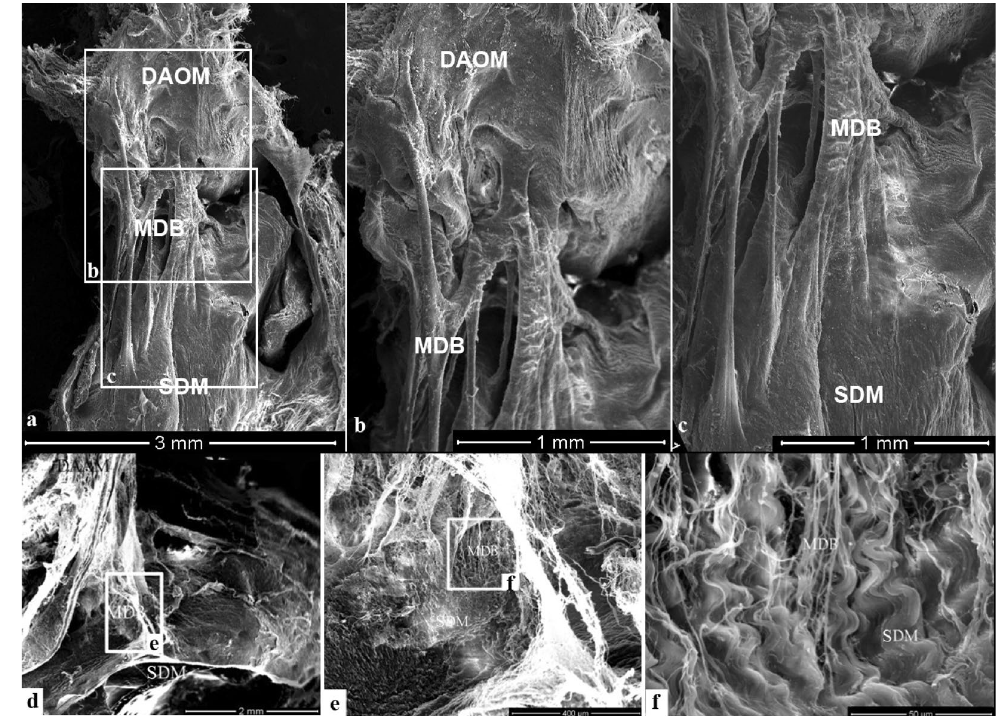
Figure 5. Connections between the DAOM and SDM or between the DAAM and SDM showed under the SEM. Figure ( b ) and ( c ): Magnification of the boxes in figure ( a ). Figure ( e ): Magnification of the box ( e ) in figure ( d ). Figure ( f ): Magnification of the box ( e ) in figure ( e ). Abundant cord-like tissues were a terminal part of the MDB, connecting the DAOM to the SDM (Fig. 5a). These connective cords were fused compactly with the DAOM (Fig. 5b) and the SDM (Fig. 5c) respectively. The DAAM gave off bundle of plexiform collagen fibers (Fig. 5d), which were woven into the collagen fibers array of SDM (Fig. 5e,f), thus anchoring the SDM to the DAAM. DAOM: Dorsal atlanto-occipital membrane; DAAM: Dorsal atlanto-axial membrane; MDB: Myodural bridge; SDM: Spinal dura